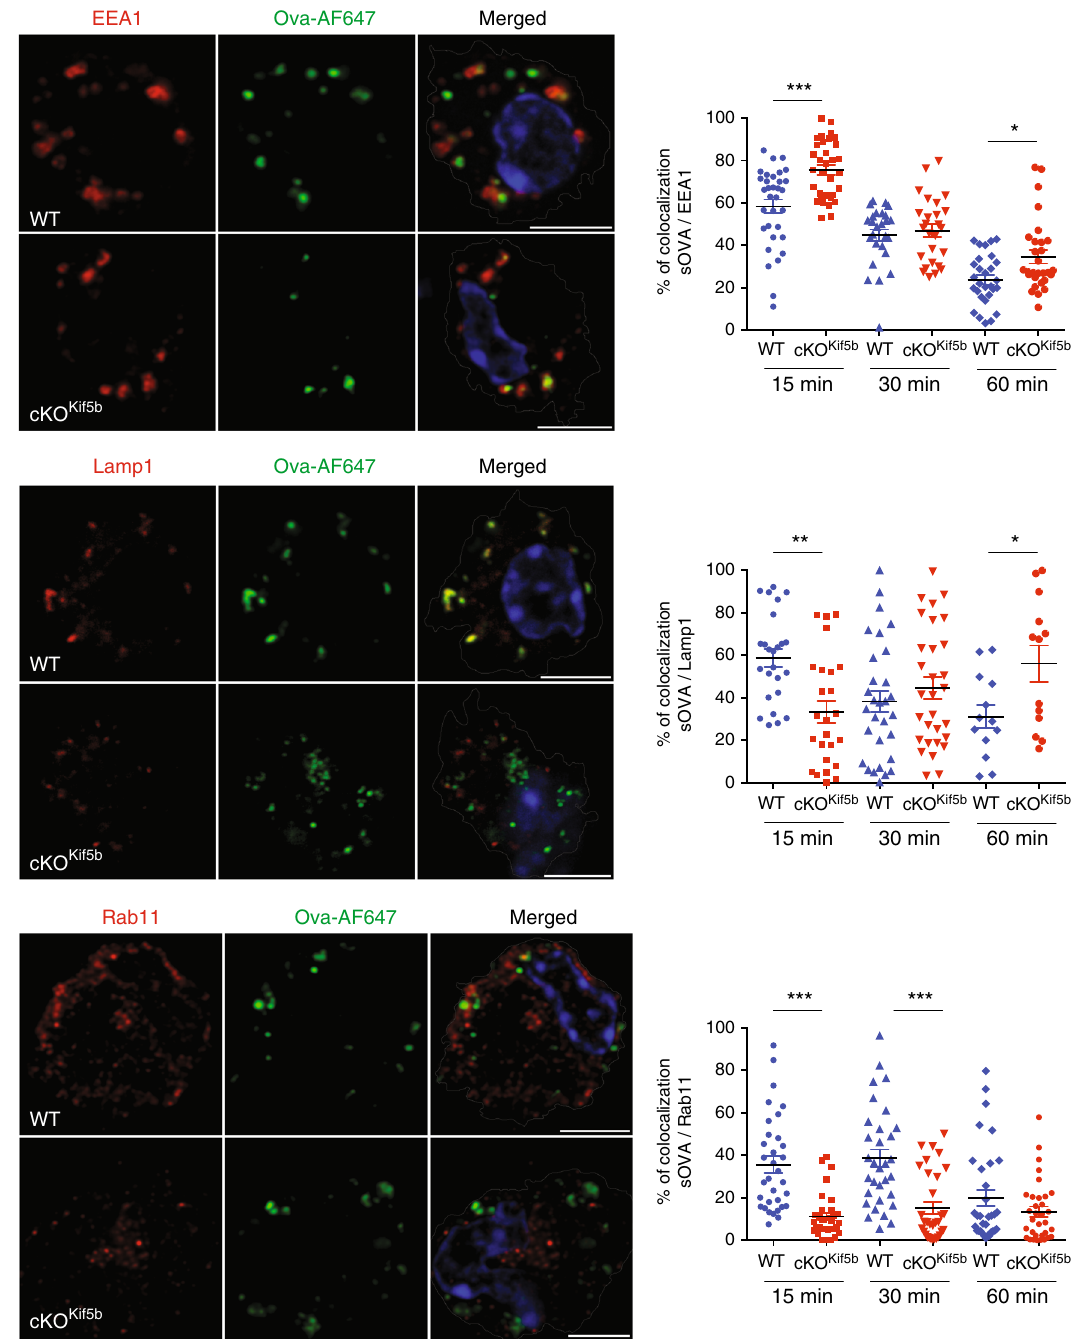
Fig. 4 Kinesin-1 regulates the intracellular traf fi cking of sOVA. BMDCs from WT or cKO Kif5b mice were incubated for 15, 30 or 60 min with Alexa-Flour- 647-OVA and then plated on glass coverslips. The cells were fi xed, permeabilized and stained with anti-EEA1, anti-Lamp1 or anti-Rab11 antibodies. The left panel shown representative images for the 15 min time point observed in three independent experiments. Bars: 5 μ m. n = 32 cells per condition. Statistical signi fi cance (shown in the right panel; WT blue circle, cKO Kif5b red square) was determined by the two-way ANOVA and Sidak test ’ s correction for multiple comparison. ** P < 0.005; *** P < 0.0001. Graphs show mean ±